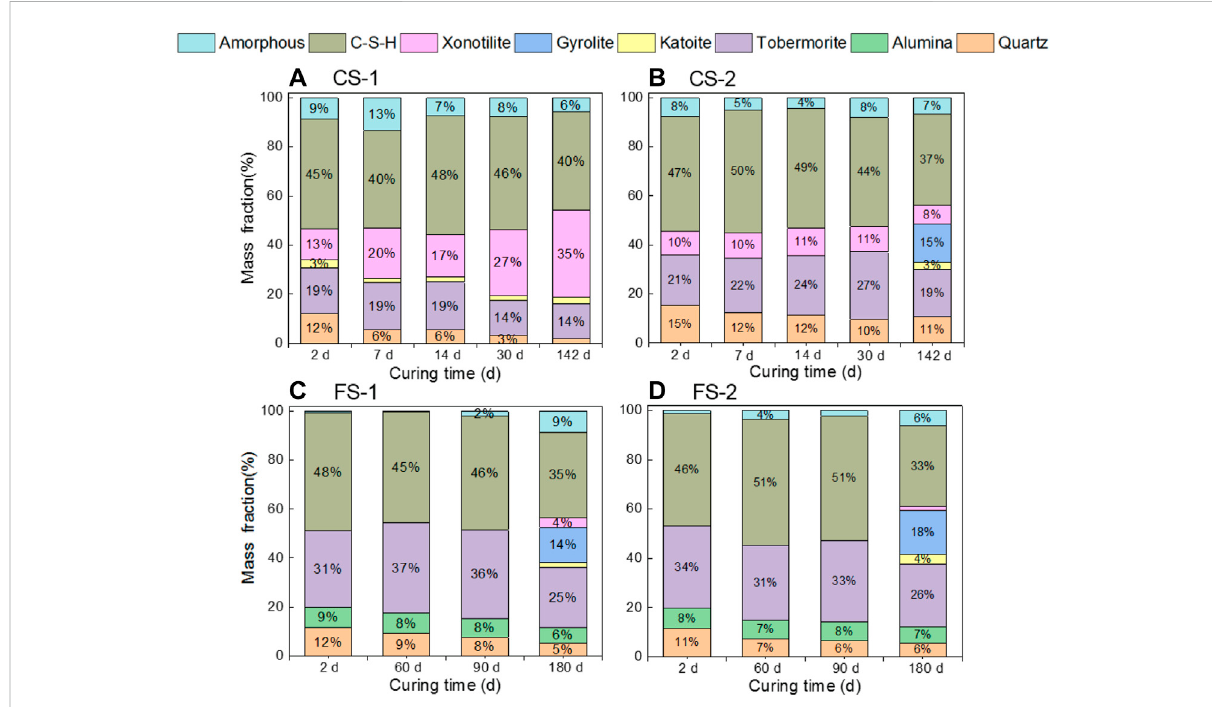
FIGURE 9 (A – D) Phase compositions of hydrated cement quanti fi ed using the hybrid method at various curing times.